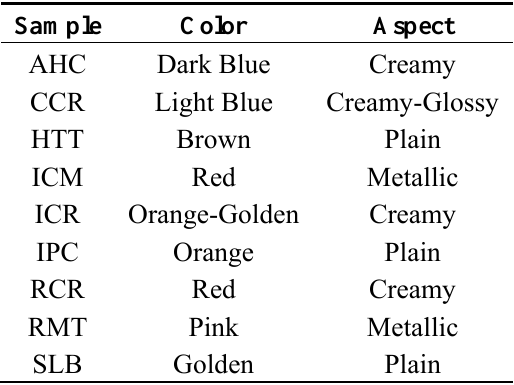
Table 2. Nail polish samples and their color assignment. The third column refers to the observed aspect of the product.